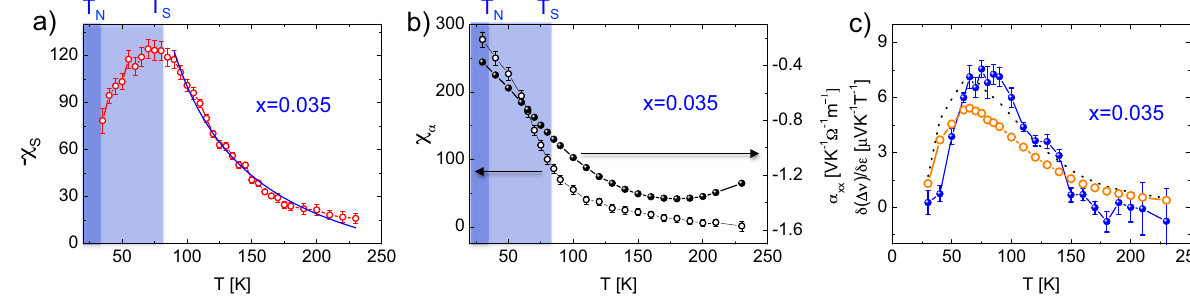
Fig. 4 Analysis of the transport coef fi cients of the x = 0.035 compound. a Temperature dependence of − χ S (red circles with solid line) for the x = 0.035 compound. The blue solid line is the Curie – Weiss fi t. b Temperature dependence of χ α (empty circles with solid line) and α xx (black circles with solid line) for the x = 0.035 compound. c Temperature dependence of experimental δ ( Δ ν )/ δ ϵ (blue circles with blue solid line) and calculated δ ( Δ ν )/ δ ϵ (orange empty circles with solid line) for the x = 0.035 compound. The black dotted line represents the calculated δ ( Δ ν )/ δ ϵ multiplied by a factor 1.2. The error-bars represent the standard